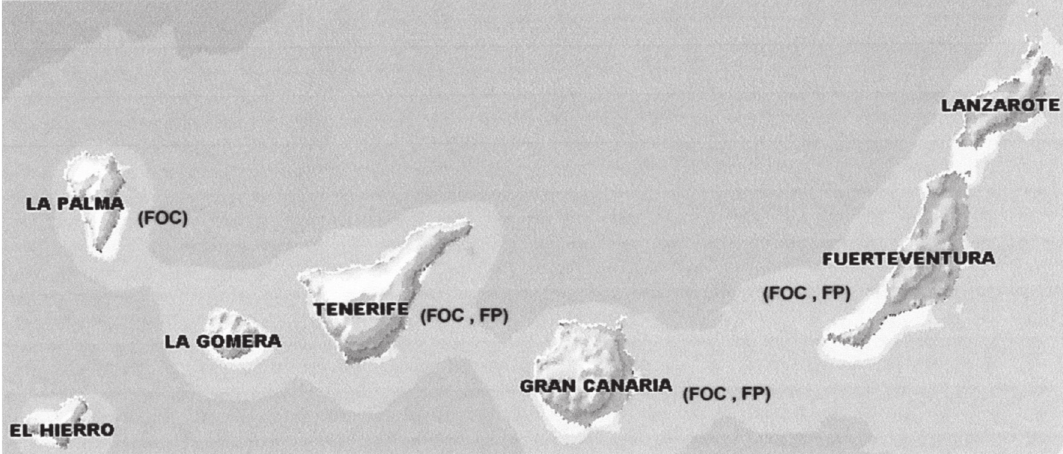
Figure 2. Map of the Canary Islands showing the distribution of Fusarium oxysporum f. sp. canariensis (FOC) and F. proliferatum